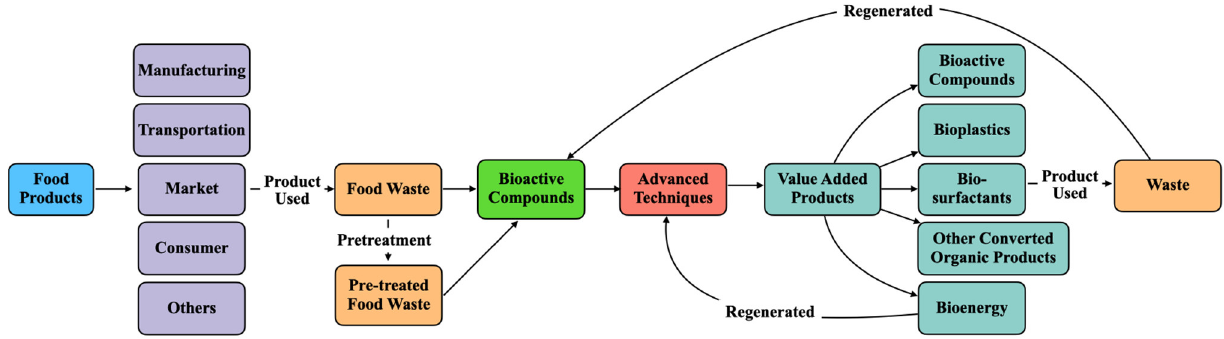
Figure 1. Sources of food waste and opportunities for its conversion into value-added